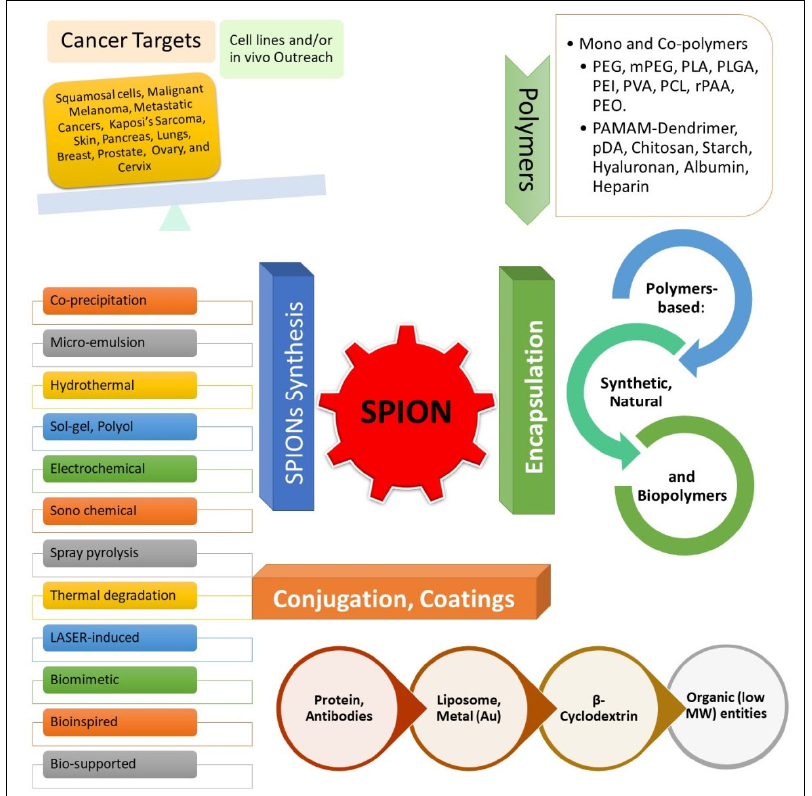
Figure 3. SPIONs preparative methods, encapsulation, conjugation, coatings, payloads, and